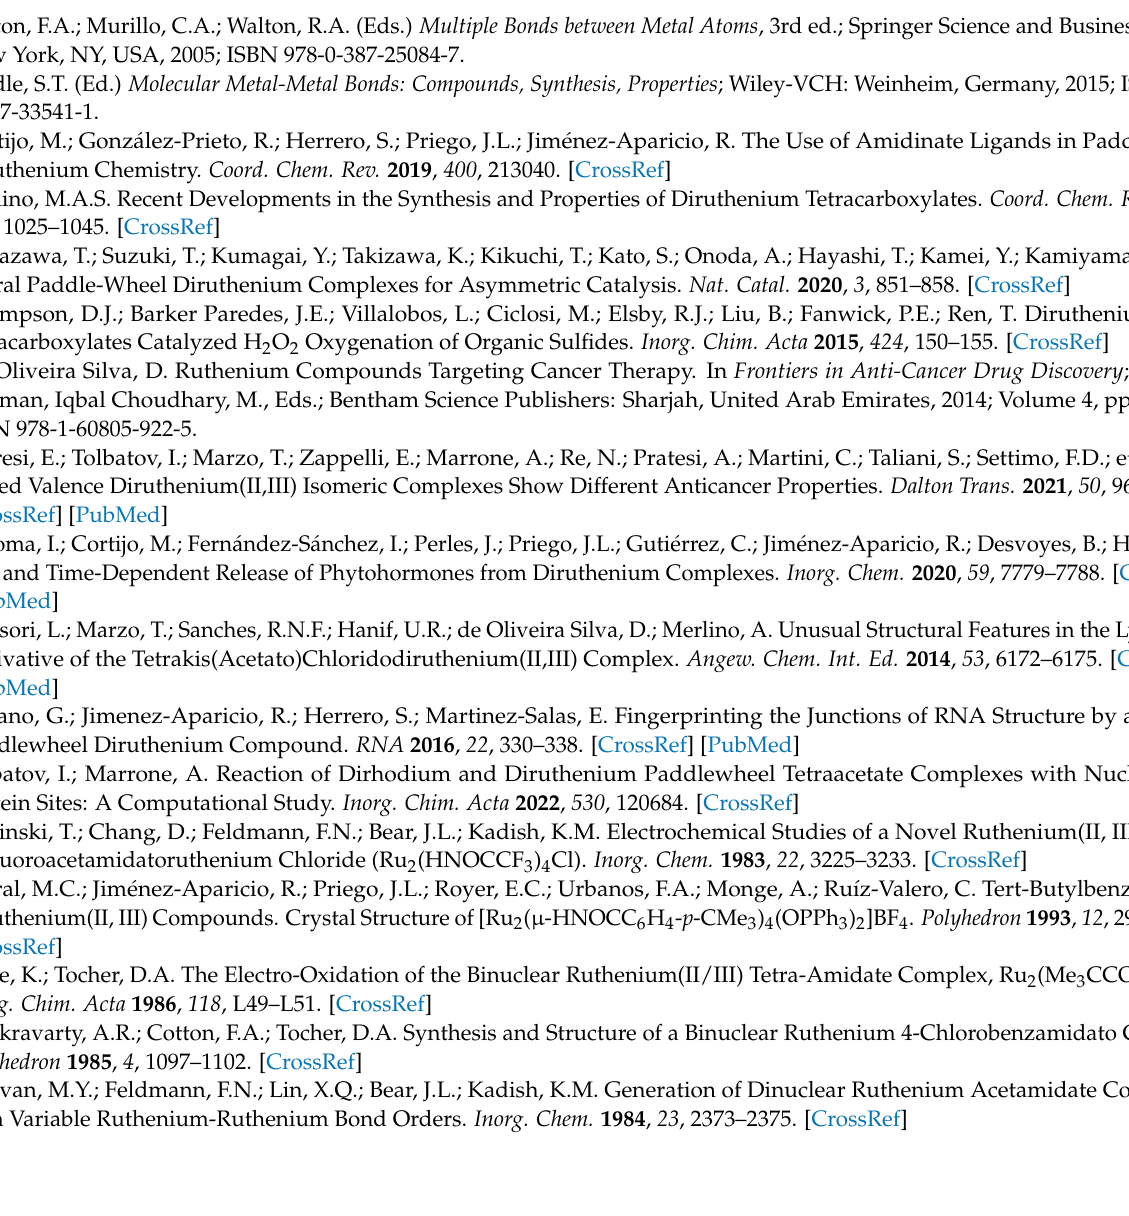
Figure S4: Temperature dependence of the molar susceptibility (o) and magnetic moment ( ∆ ) for compound [Ru 2 Cl( µ -O 2 CC 6 H 4 - o -OMe) 4 ] n ( 1a ). Table S1: θ angles between carboxylate plane and aromatic ring plane in compounds 1b and 1c . Table S2: Angles between aromatic ring plane and methoxy substituent plane in compounds 1b and 1c